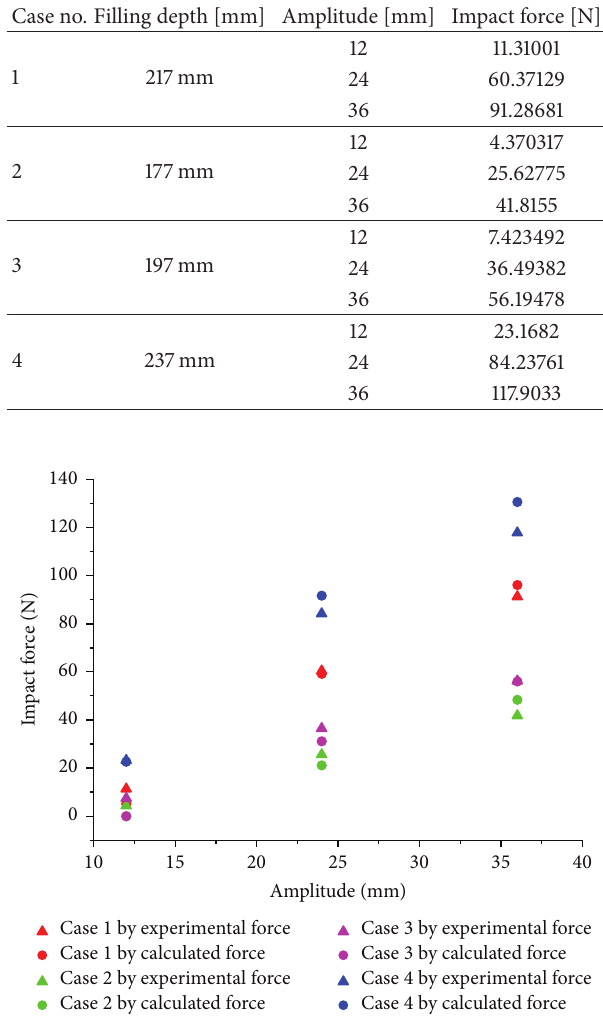
Figure 8: Comparison of calculated force and experimental